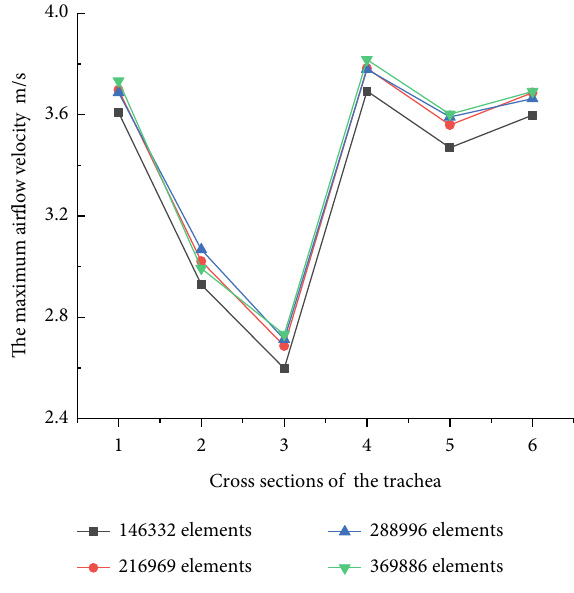
Figure 3: Selected lines and planes for velocity pro fi